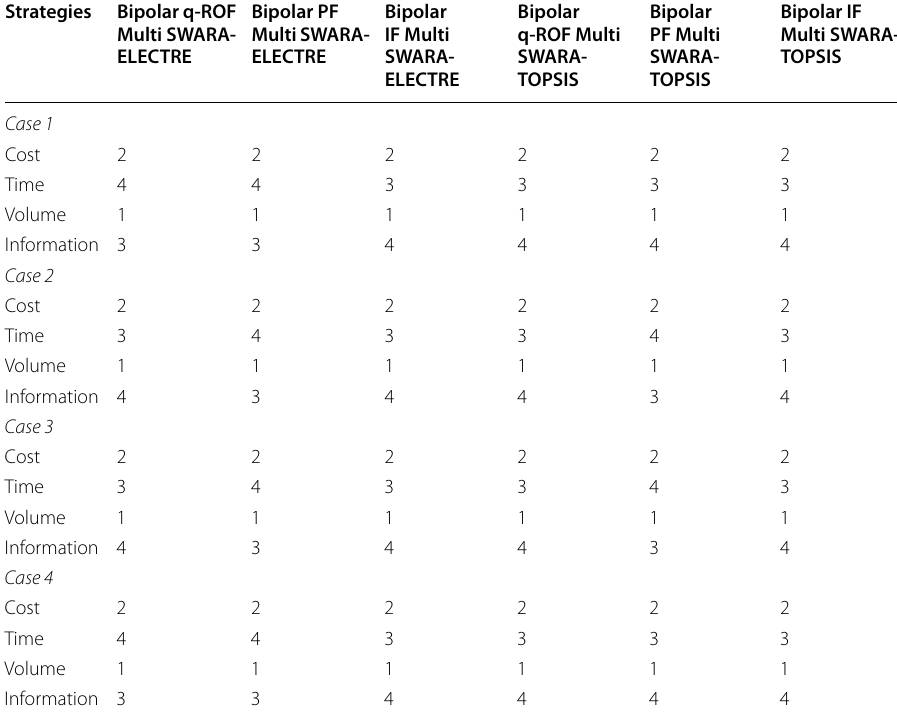
Table 20 Validation and sensitivity analysis results